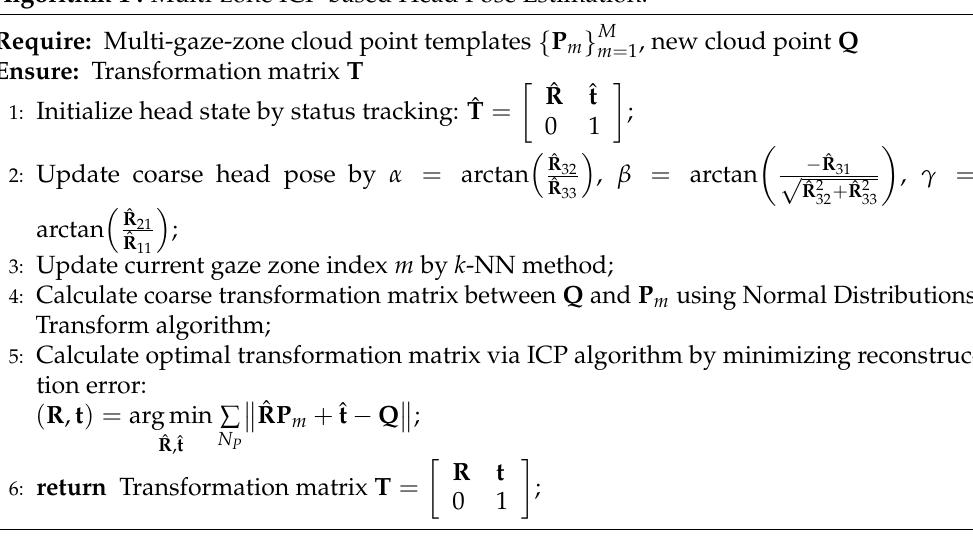
Algorithm 1 : Multi-zone ICP-based Head Pose